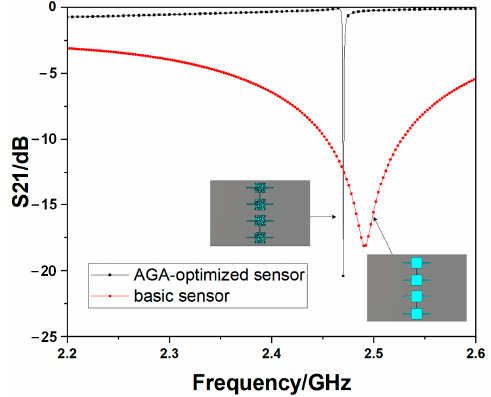
Figure 6. Simulation results for the two kinds of structures.